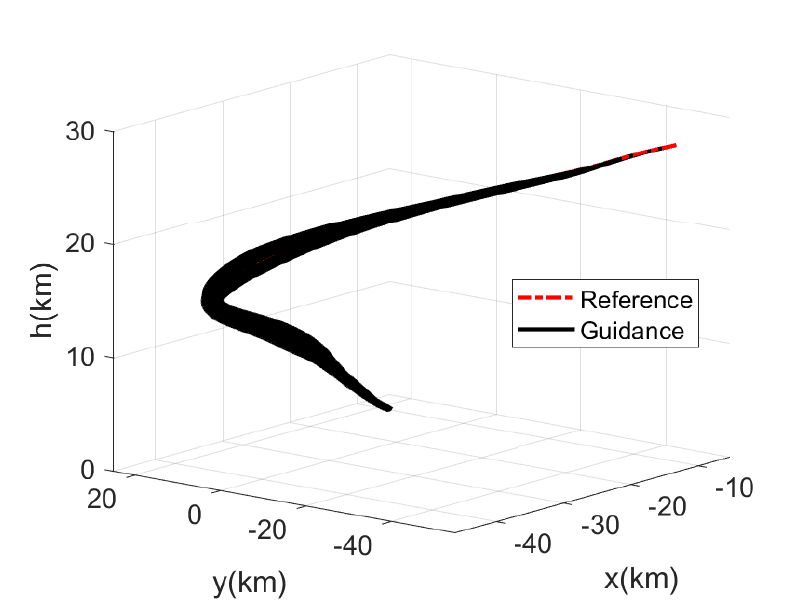
Figure 3. Three-dimensional TAEM trajectories of RLV in Monte Carlo simulation.